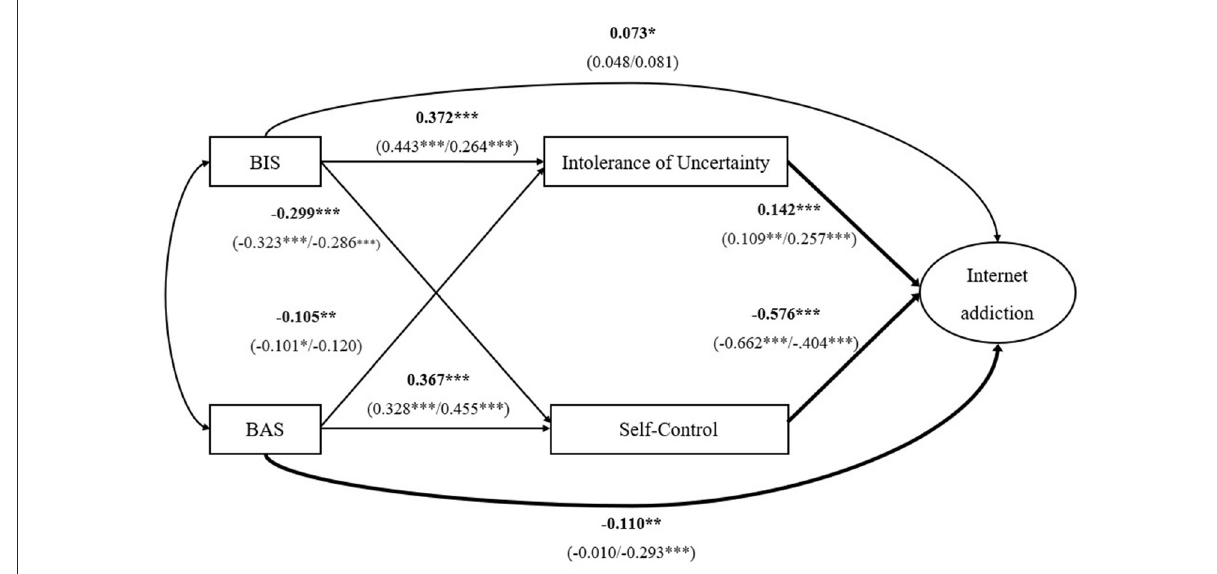
FIGURE2 The relationships among BIS, BAS and Internet addiction are mediated by IU and Self-Control. Bold lines indicate significant gender differences in these paths. The parameters for whole participants are displayed outside of the parentheses, while the parameters for different subgroups are denoted within the parentheses (females in the left, males in the right) * p < 0.05, ** p < 0.01, *** p <